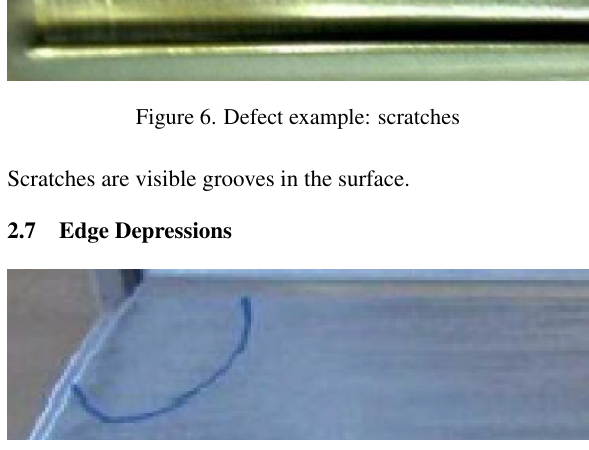
Figure 7. Defect example: edge depression Edge depressions slight depressions on the surface near edges.